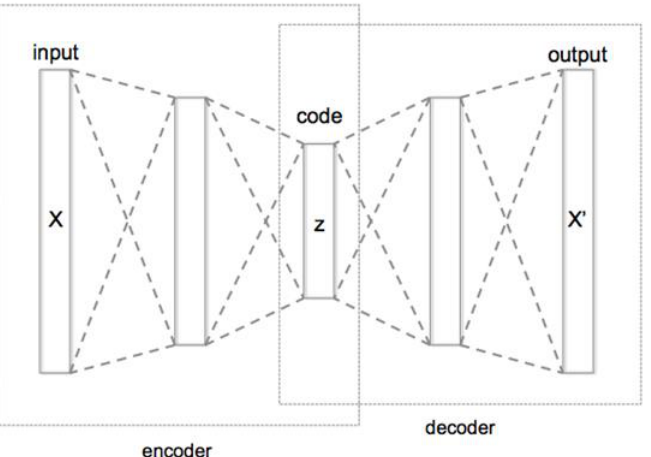
Figure 3. Base structure of a Deep Autoencoder for dimensionality reduction. The autoencoder is a deep learning structure usually composed of an encoder component and a subsequent decoder component. To generate a representation of some data X in the form of an embedding, the autoencoder is trained to reproduce X. This means that the loss of the training is computed between the decoder output X’ and the input X. The purpose is to reproduce an output that is as similar as possible to the input. Once this goal is reached with the desired level of accuracy, it means that the decoder can properly reproduce the data from the encoder representation z, which is usually a lower dimension version of the input data